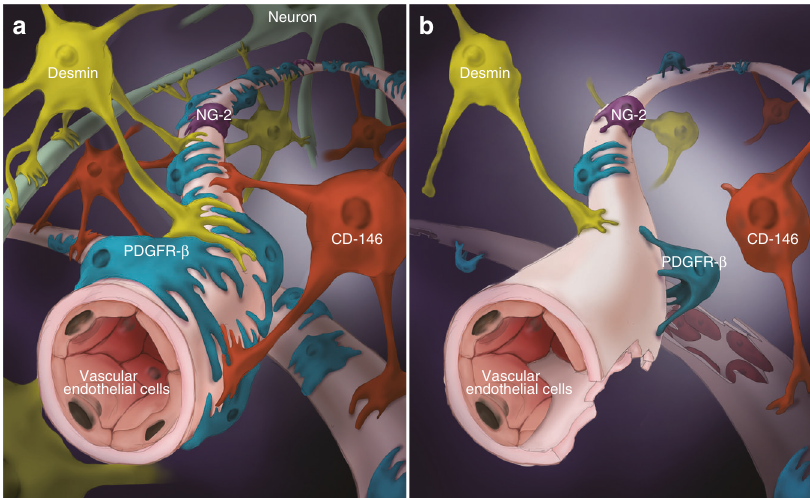
Fig. 1 Pericytes in SCI. Schematic representation of the localization, morphology, and coverage of common subtypes of pericytes and vascular endothelial cells in normal spinal cord ( a ) and injured spinal cord ( b